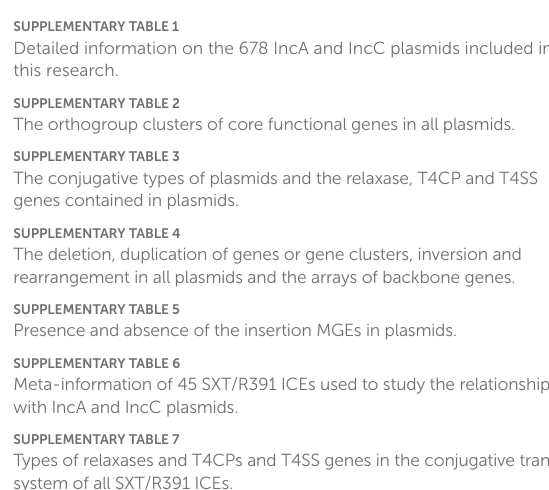
SUPPLEMENTARY TABLE 7 Types of relaxases and T4CPs and T4SS genes in the conjugative transfer system of all SXT/R391